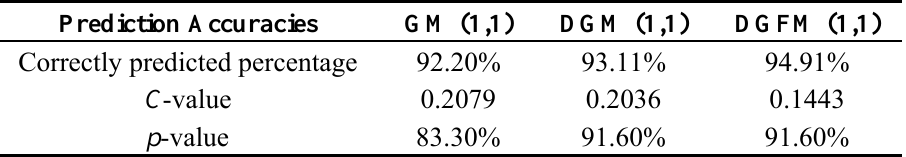
Table 10. Comparison of the three models in terms of prediction